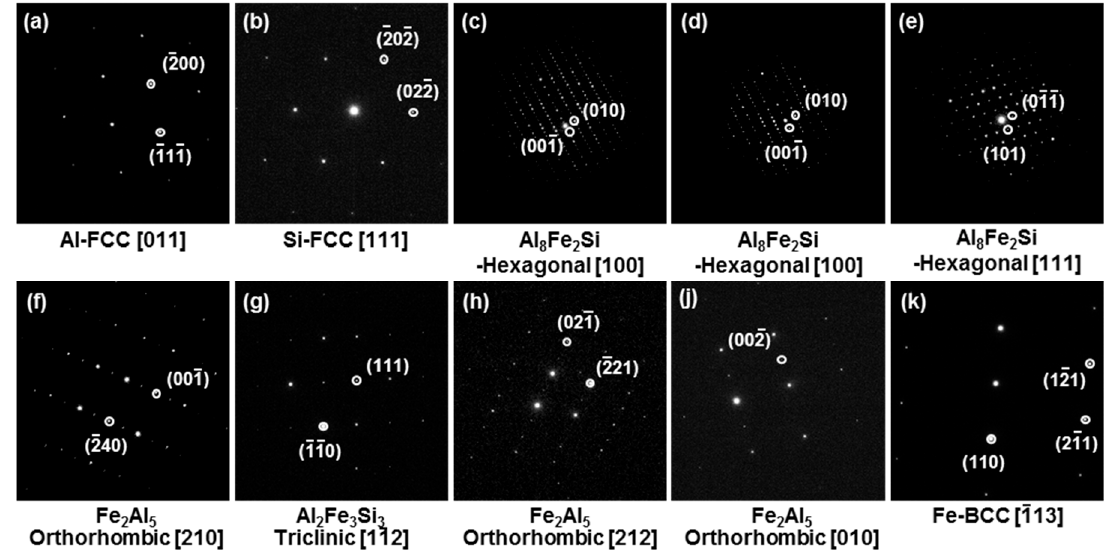
Figure 6. Diffraction patterns and those key diagram taking from at area denoted as 1–10 in Figure 5a, respectively.